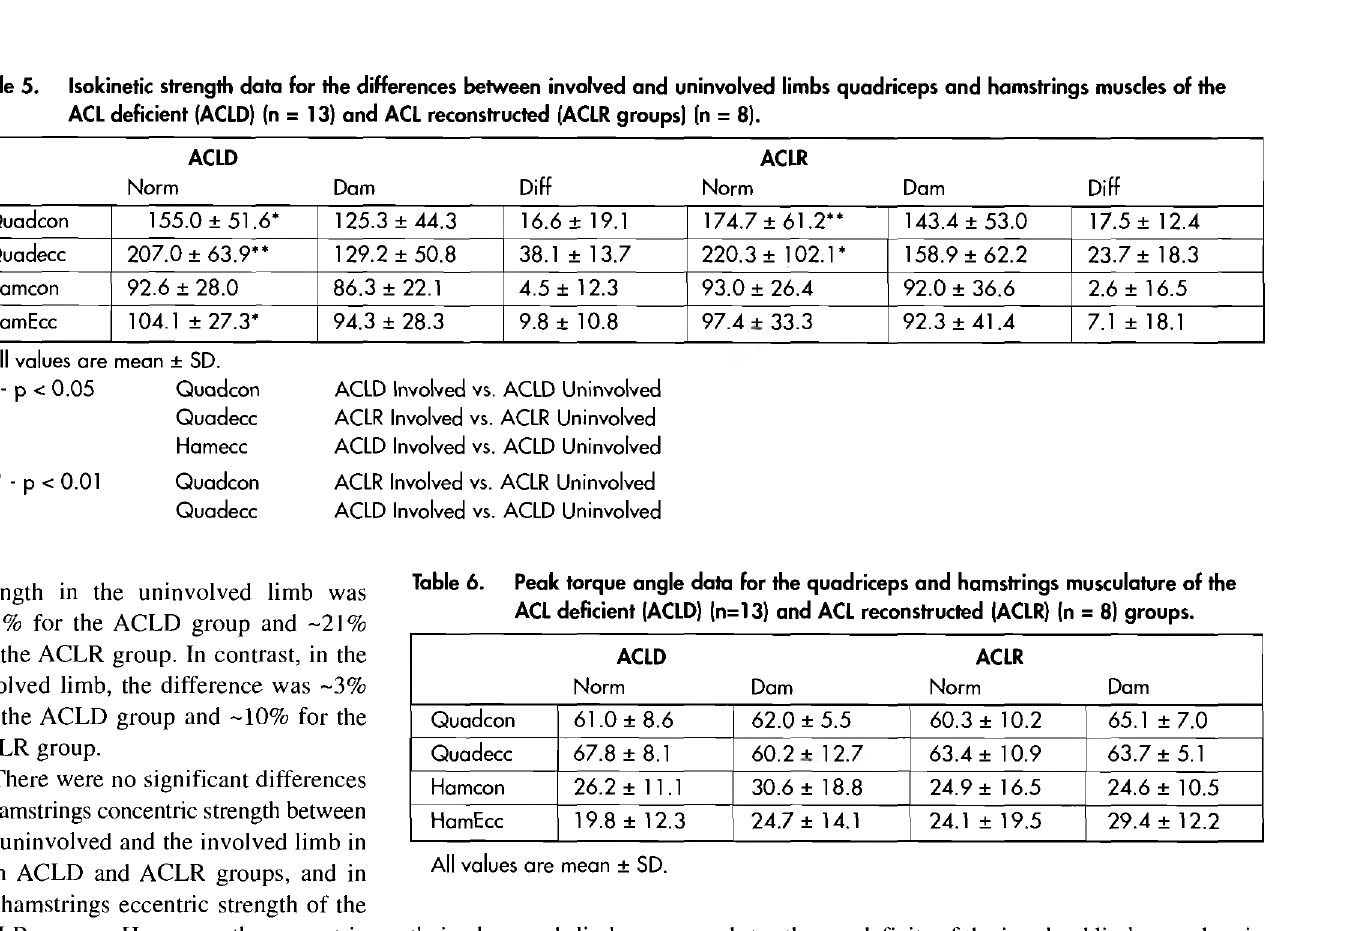
Peak torque angle data for the quadriceps and hamstrings musculature of the ACL deficient (ACLD) (n=13) and ACL reconstructed (ACLR) (n = 8)